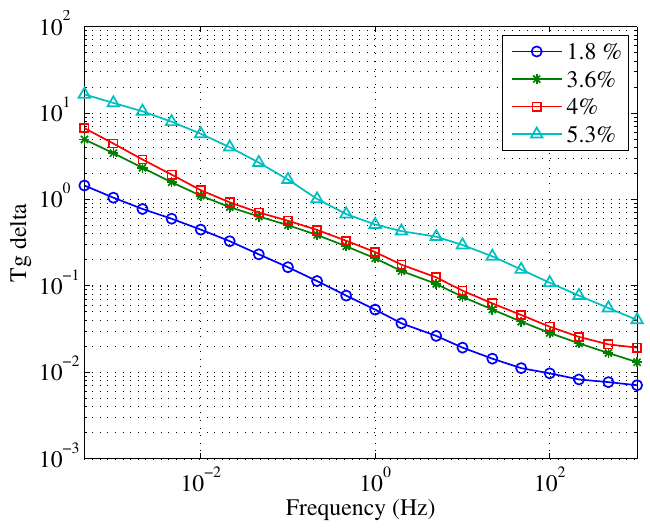
Figure 6. Tangent δ measured with Mesh B over samples with different moisture levels immersed in mineral